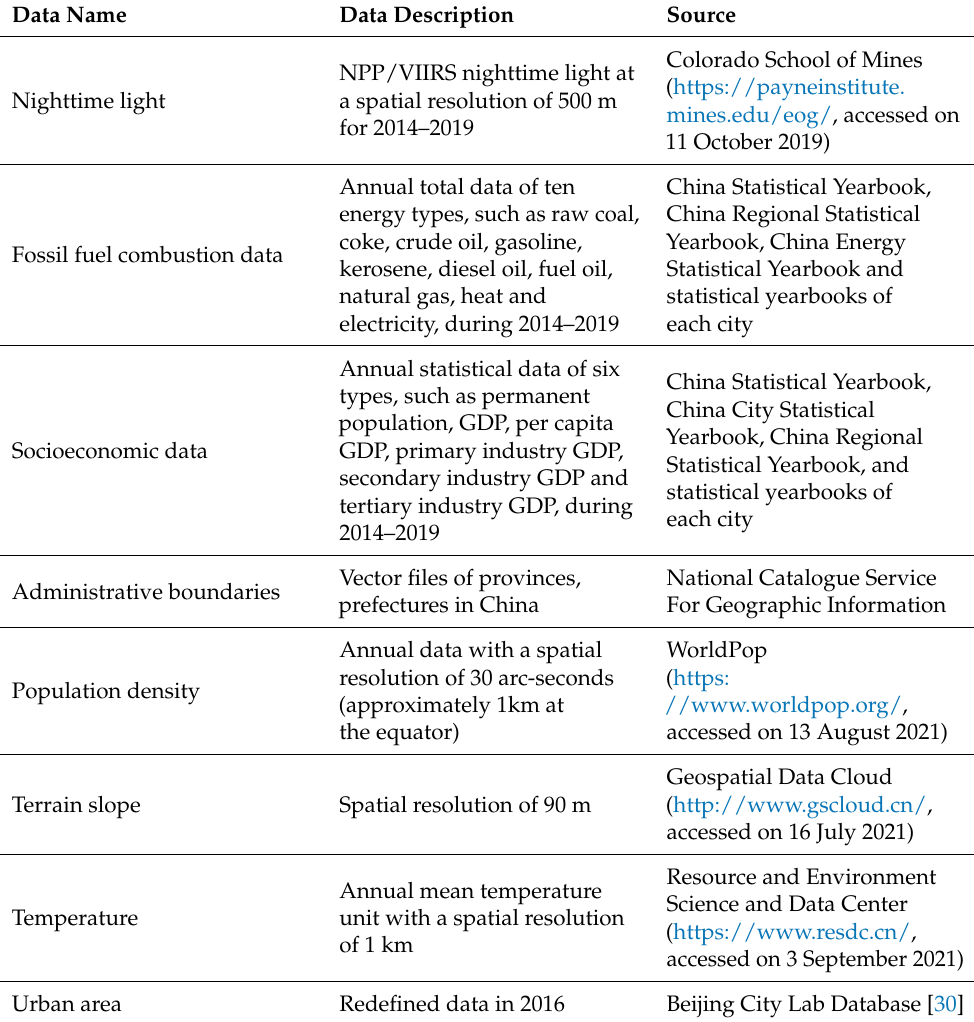
Table 1. Data used in this